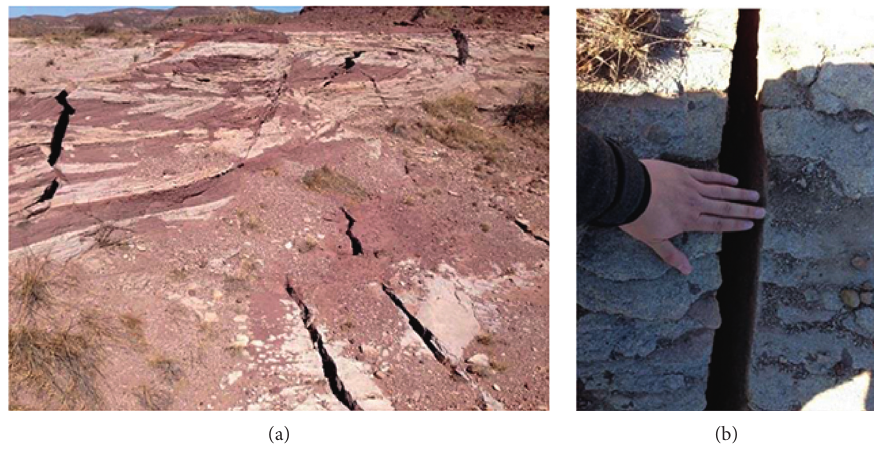
Figure 5: Morphology of surface cracks in bedrock exposed